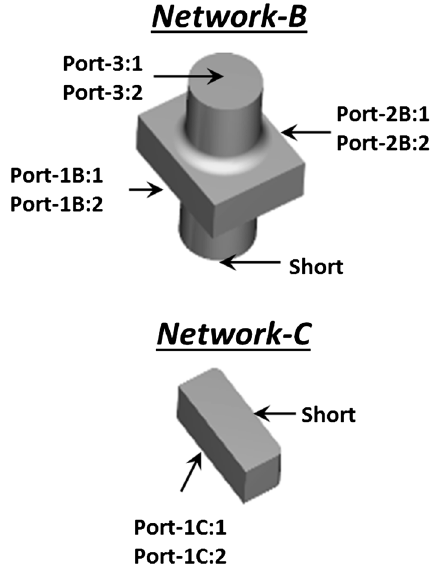
FIG. 3. Subnetworks A and BC used for the second cascade of the polarizer model with labeled port